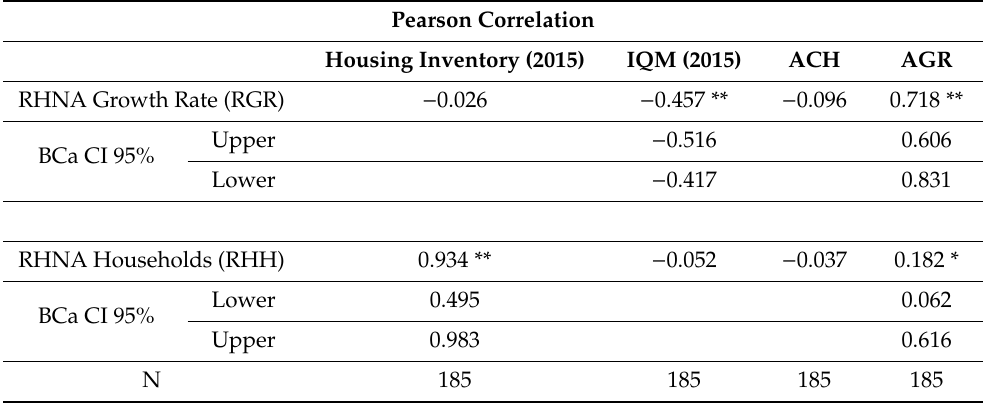
Table 3. The Pearson correlation analysis of the